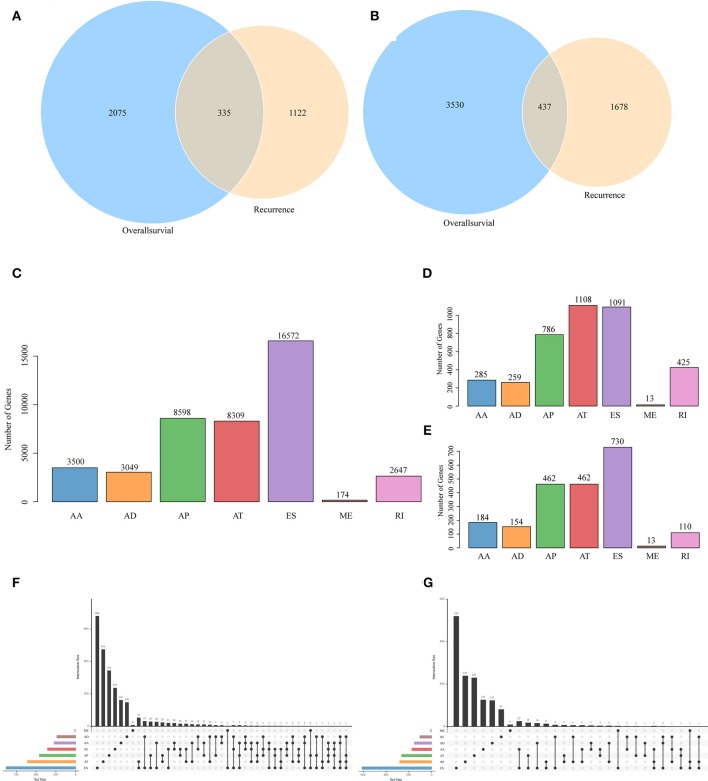
Venn diagram of AS events (A) and involved genes (B) that were significantly correlated with OS and recurrence. (C) Distribution of AS events of seven types. (D) Distribution of OS-associated AS events of seven types. (E) Distribution of recurrence-associated AS events of seven types. The UpSet intersection diagram shows seven types of OS (F)—and recurrence (G)—associated AS events in HNSCC. One gene may have up to four types of alternative splicing associated with patient survival or recurrence.